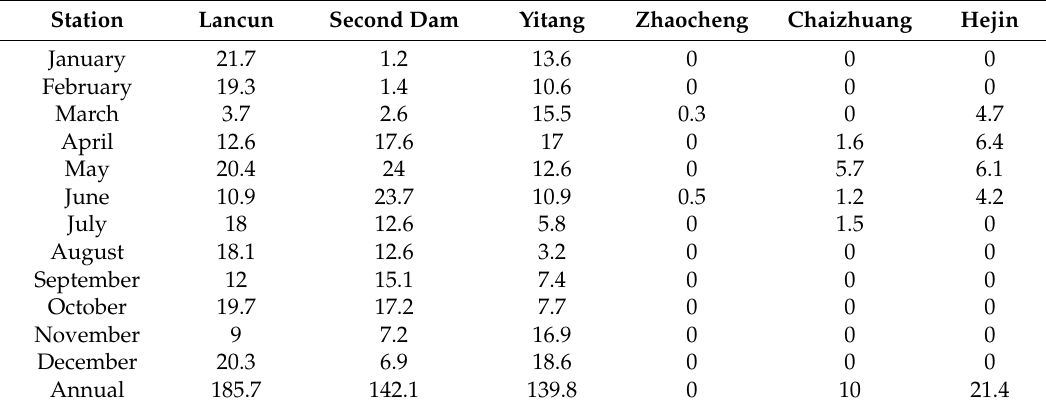
Table 9. Monthly average of number of dry days at hydrological stations on the main stream of the Fenhe River from 1997 to 2006 (Units =